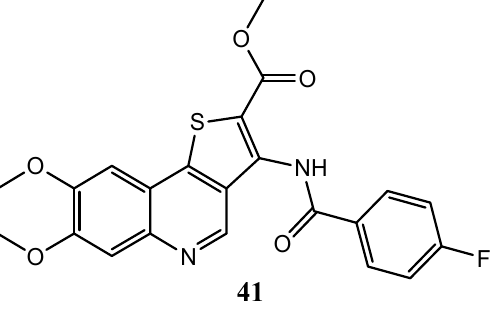
Figure 15. Thieno[3,2- c ]quinoline compound active as PI3K inhibitor [104].